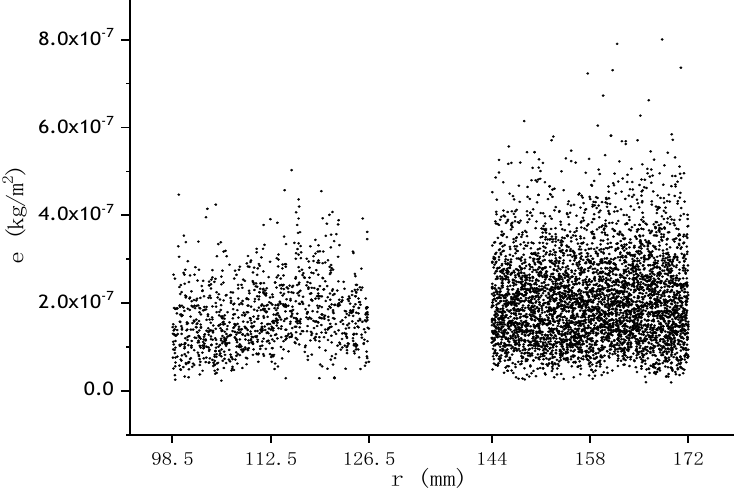
Figure 11. Wear distribution of the test sample under condition 1.